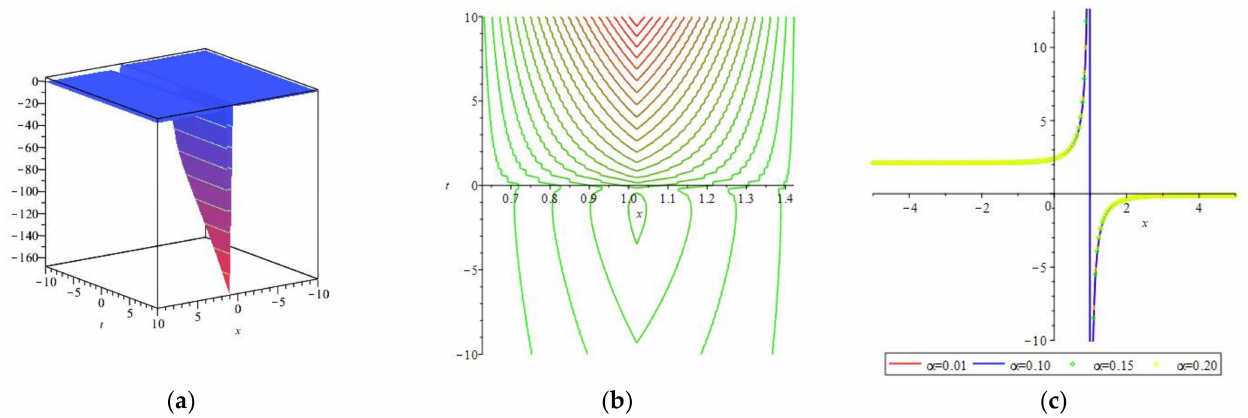
Figure 2. The graphical representation of the solution λ 12 ( χ ) : ( a ) 3D shape, ( b ) contour plot, and ( c ) 2D graph.